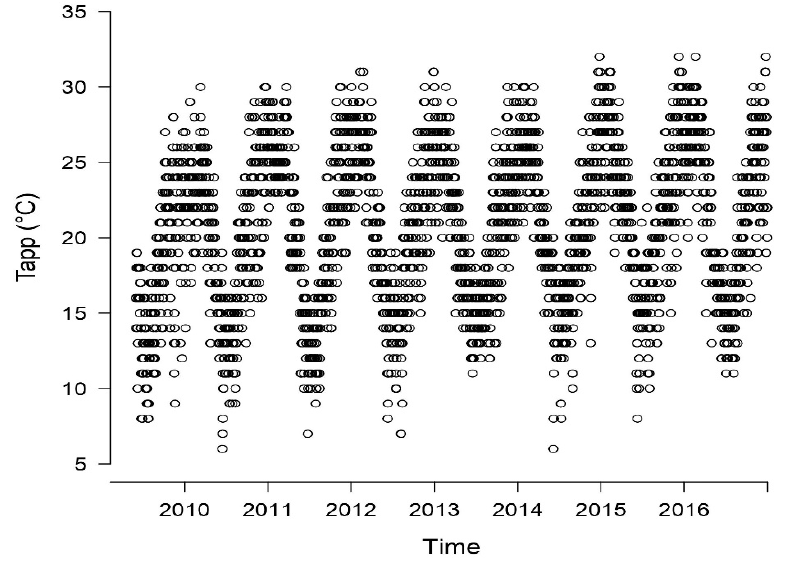
Figure 3. Trends in calculated T app during the study period. Each dot represents the daily T app calculated with weather data from the Thohoyandou weather station.